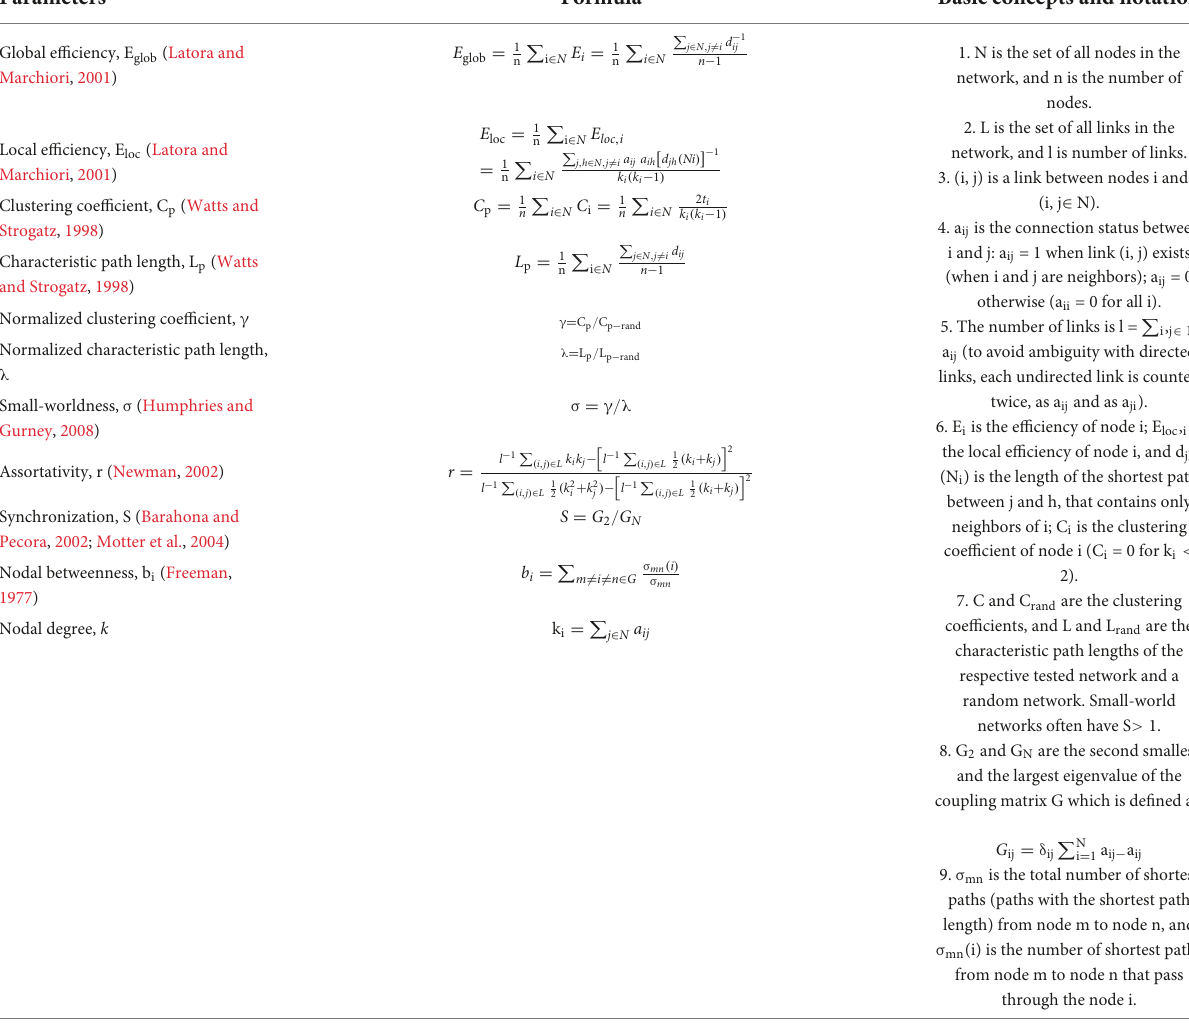
TABLE 1 Mathematical definitions of network metrics.